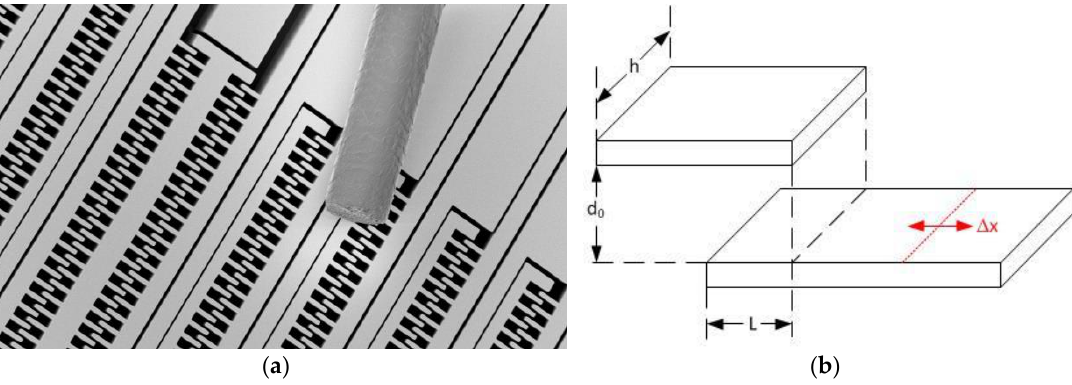
Figure 2. Accelerometer Lateral Design: ( a ) SEM image showing the large number of electrodes needed to achieve reasonable sensitivity; ( b ) Electrode scheme.